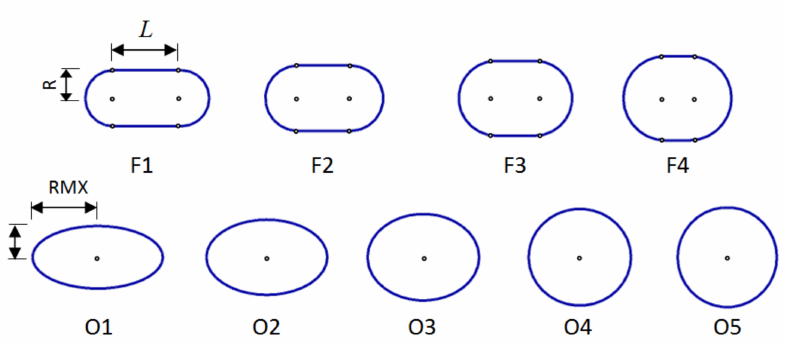
Figure 2. Schematic of different flat and oval tube geometries (RMN = minor axis radius, RMX = major axis